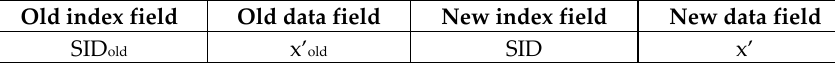
Figure 2. Tags’ index data table in Fan et al.’s scheme. Sensors 2020 , 20 , x FOR PEER REVIEW